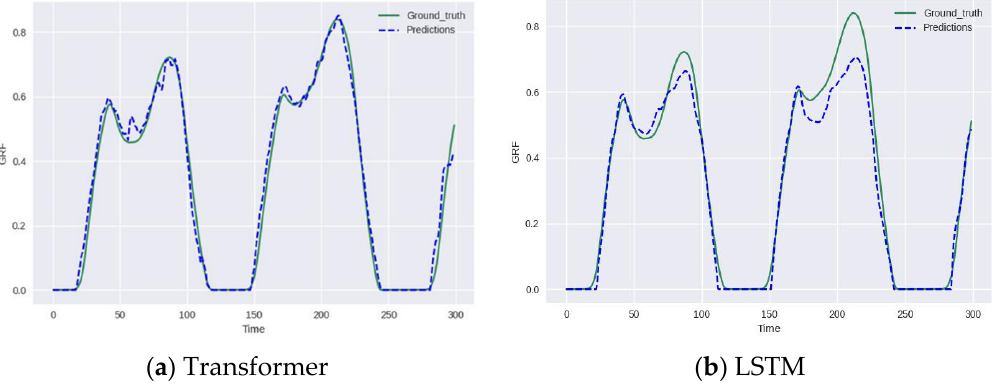
Figure 4. We compare the performances of the transformer ( a ) and LSTM ( b ) on the prediction GRF task. The green solid line indicates ground truth and the blue dashed line indicates predicted value.